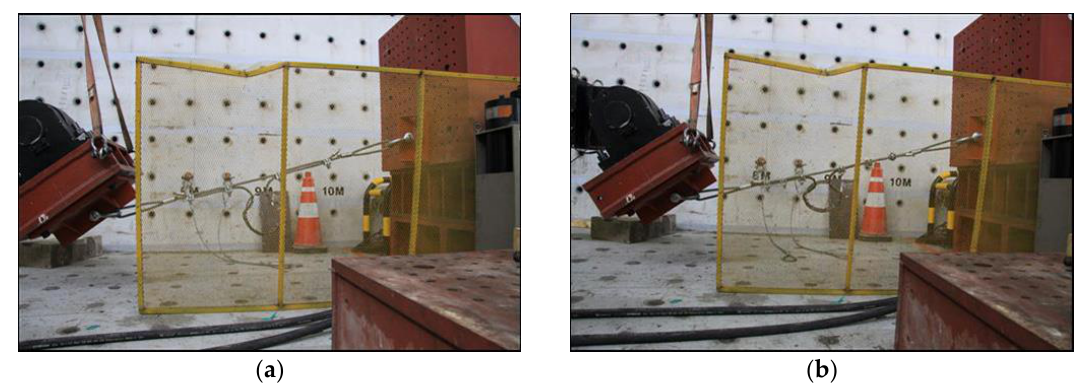
Figure 3. Quasi-static load tests using different sets of U-clips, ( a ) brake frame using four U-clips; and ( b ) brake frame using six U-clips.